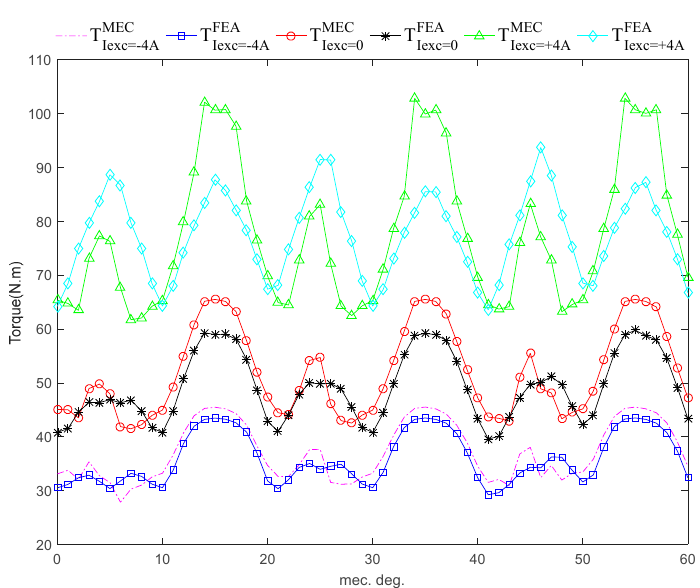
Figure 30. Torque vs. rotor position (MEC and FEA comparison) (170 rpm, J max = 10 A/mm²).